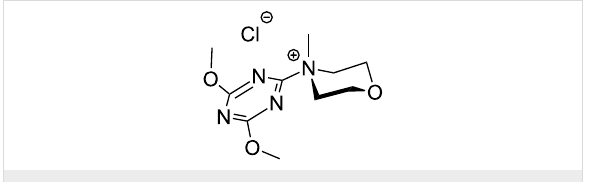
Figure 3: DMT-MM in its presumably more stable conformation